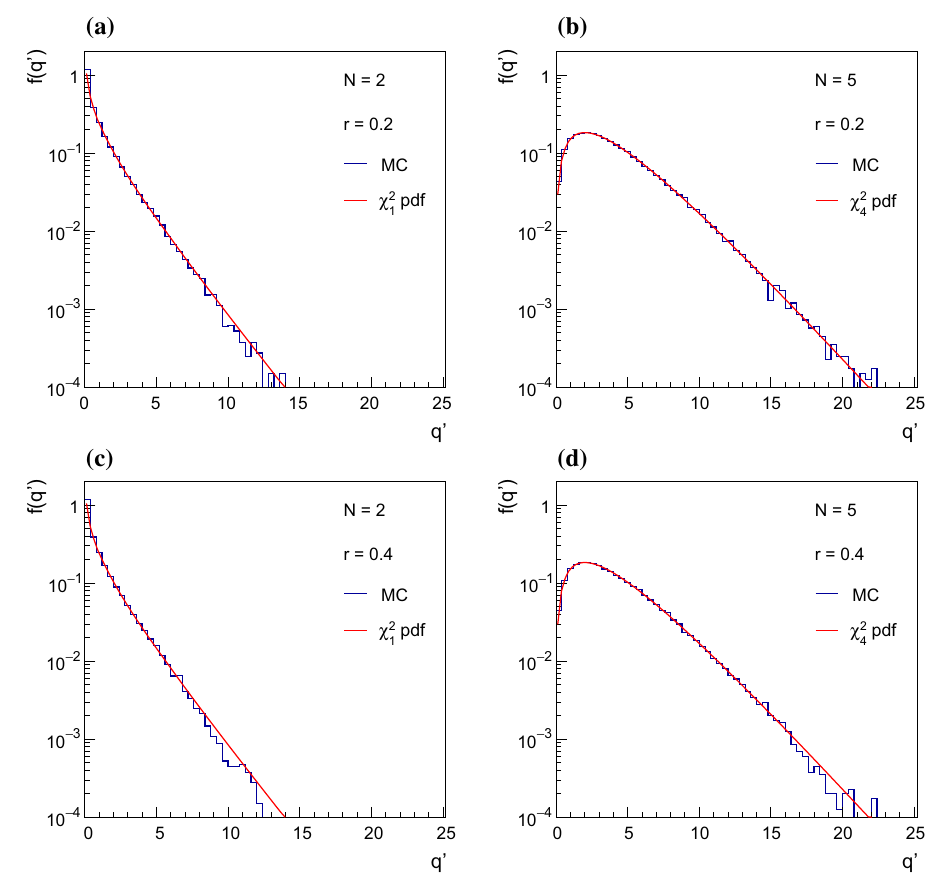
Fig. 6 Distributions of the Bartlett-corrected test variable q (cid:6) for averages of N = 2 and 5 values using r = 0 . 2 and r = 0 .